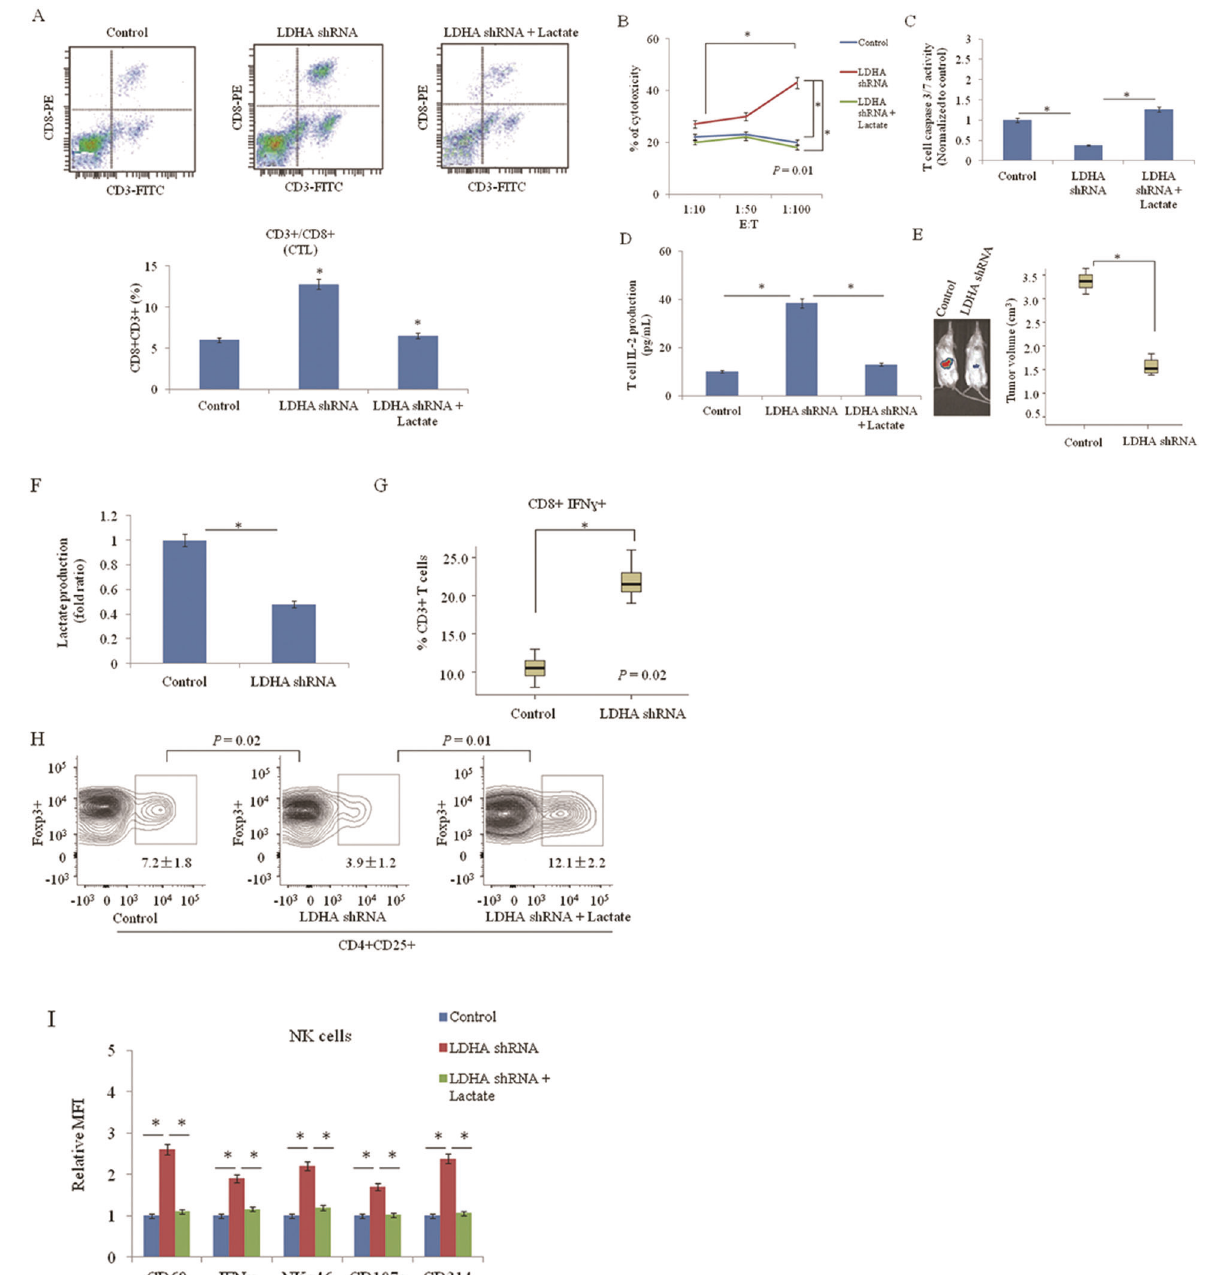
Fig. 6 Notch1 signaling induced lactate inhibits cytotoxic T cell activity. a Flow cytometric analysis of cytotoxic T lymphocytes (CTL) in coculture of primary T cells and A549 cells transfected with LDHA shRNA with or without 10 mmol/L lactate treatment for 96 h. * P < 0.05. b CTL cells isolated from untreated lung cancer patients were cultured in vitro for 3 days and 7 days, respectively. A549 cells were transfected with LDHA shRNA. CTL cells were incubated with A549 cells with or without lactate for 96 h at different E:T ratio (1:10, 1:50, and 1:100). Cytotoxicity of CTL cells toward lung cancer cells was determined by LDH release assay (* P < 0.001, when effector cells were stimulated with lactate in comparison to unstimulated cells). c , d T cell Caspase 3/7 activities ( c ) and IL-2 level ( d ) were measured in CTL cells incubated with A549 cells transfected with LDHA shRNA with or without 10 mmol/L lactate treatment. N = 3. * P < 0.05. e Representative images of tumor growth of LDHA shRNA-expressing A549 xenograft models in BALB/c mice by bioluminescence imaging. Tumors were measured every fi ve days and dissected at day 35, and tumor size (cm 3 ) is shown in a box-and-whisker plot. N = 8 mice per group. * P < 0.05. f Lactate production in LDHA knockdown A549 xenograft tumors. * P < 0.05. g Intracellular cytokine staining of IFN ɣ in CD3 + CD8 + T-cell populations in LDHA knockdown- A549 xenograft tumors. P < 0.05, two-way ANOVA. * P < 0.05. h Flow cytometry analysis of CD4 + CA25 + Foxp3 + T regulatory (Treg) cells in LDHA knockdown-A549 xenograft tumors. Treg cells were treated with or without 10 mmol/L lactate for 96 h. i Flow cytometry analysis of activation markers of CD69, IFN ɣ , CD107a, CD314, and NKp46 in NK cells in LDHA knockdown-A549 xenograft tumors. NK cells were treated with or without 10 mmol/L lactate for 96 h. Relative MFI, mean fl uorescence